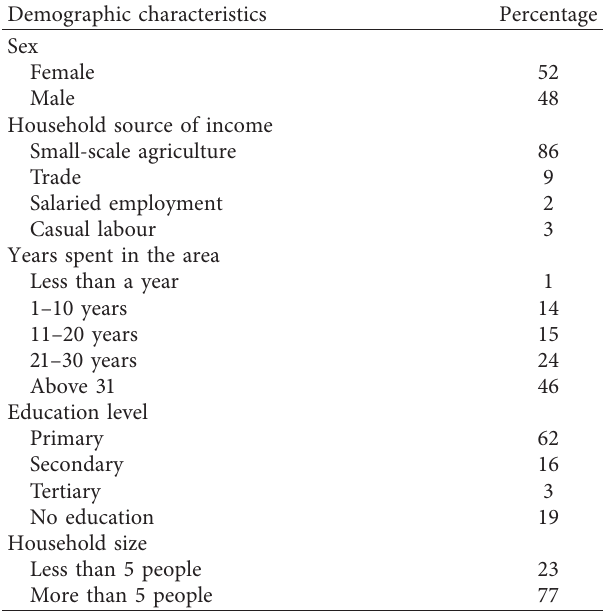
Table 3: Socioeconomic characteristics of the respondents. Demographic characteristics